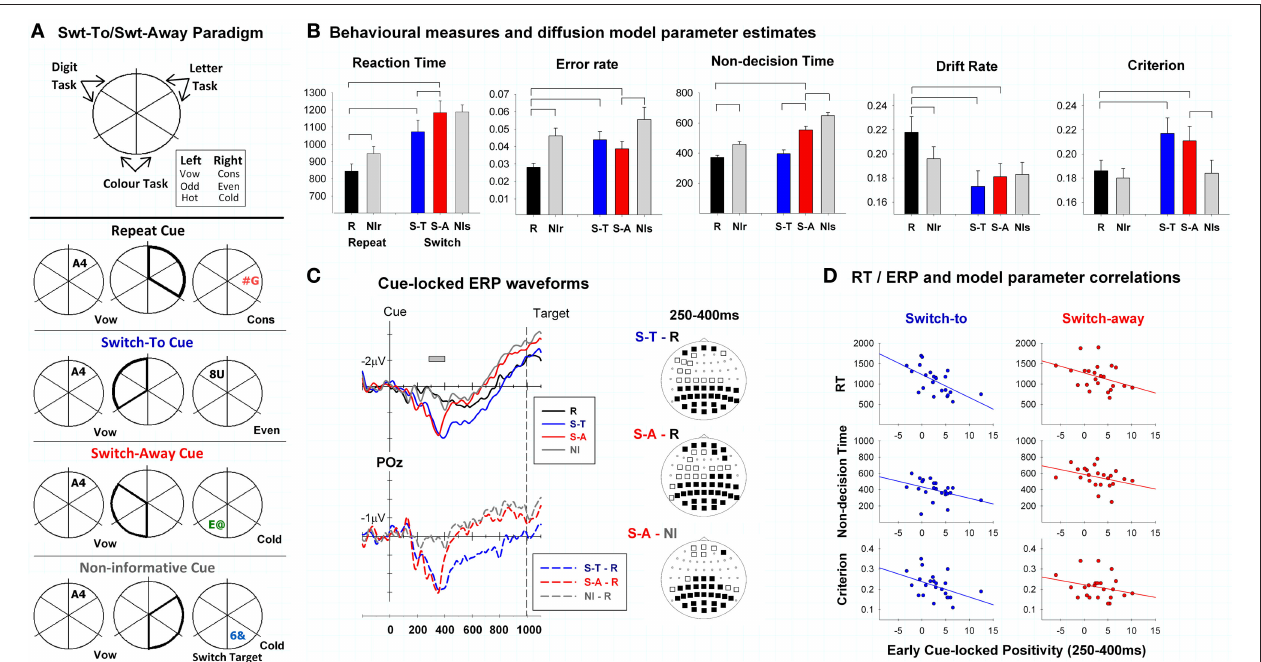
FIguRE 5 | From Karayanidis et al. (2009) . (A) Participants ( n = 24) used location based task cues to shift between three tasks. Cues could (a) validly predict a task repeat trial ( repeat cues ), (b) validly predict a shift away from the recently completed task-set and specify the upcoming task ( switch-to ), (c) validly predict a shift away from the recently completed task-set but leave task identity to target location ( switch-away ), or (d) be equally likely to be followed by a repeat or switch trial (e.g., non-informative cues leading to either a switch or repeat trial). (B) Switch-away cues resulted in more accurate but not faster responding than non-informative switch cues. Modeling of decision processes showed that this reflected differences in response criterion adjustment. Specifically, both cues that predicted a switch with certainty produced a higher response criterion than cues that predicted a certain ( repeat ) or likely ( non-informative repeat or switch ) repeat trial. This indicates trial-by-trial adjustment of response criterion depending on whether the cue provided certainty about an upcoming switch trial. These models also produce a non-decision time parameter that represents processes not directly related to the decision, such as stimulus processing